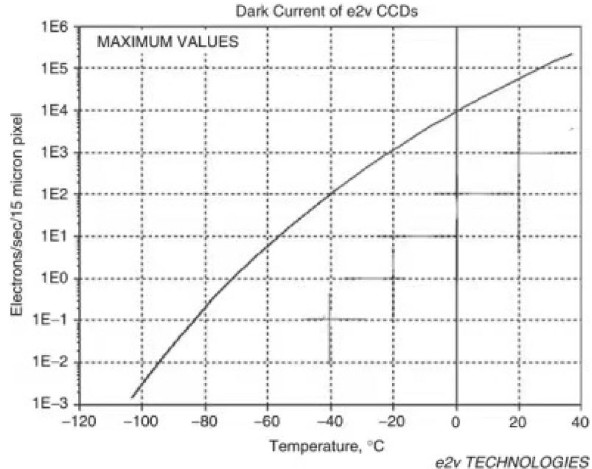
Figure 4. Relationship of dark current and operating temperature of CCD.